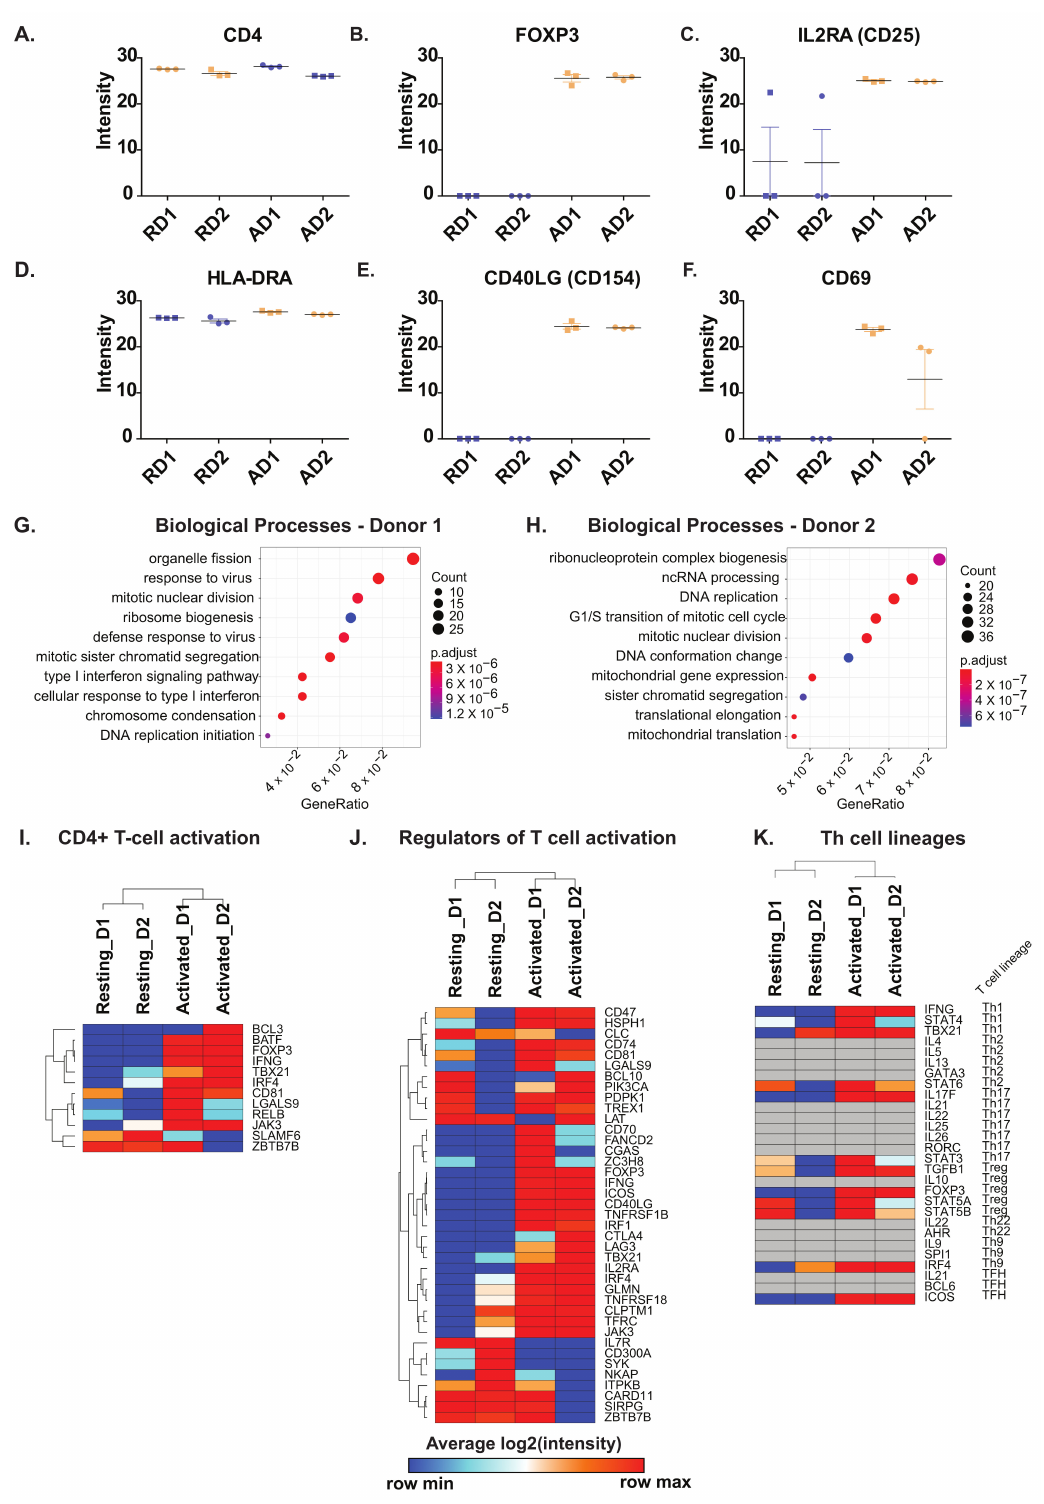
Figure 2. Protein expression levels of ( A ) CD4 ( B ) FOXP3 ( C ) IL2RA (CD25), ( D ) HLA-DRA, ( E ) CD40LG, ( F ) CD69 in resting (R) and activated (A) primary CD4+ T cells from Donor1 (D1) and Donor2 (D2). Enriched Biological Processes from proteins upregulated in ( G ) Donor 1 and ( H ) Donor 2 in response to activation. Heatmaps depicting ( I ) CD4+ T cell activation markers, ( J ) Regulators of T cell activation in CD4+ T cells and ( K ) Markers of T cell lineages. Genesets for comparison of significantly changing proteins were obtained from